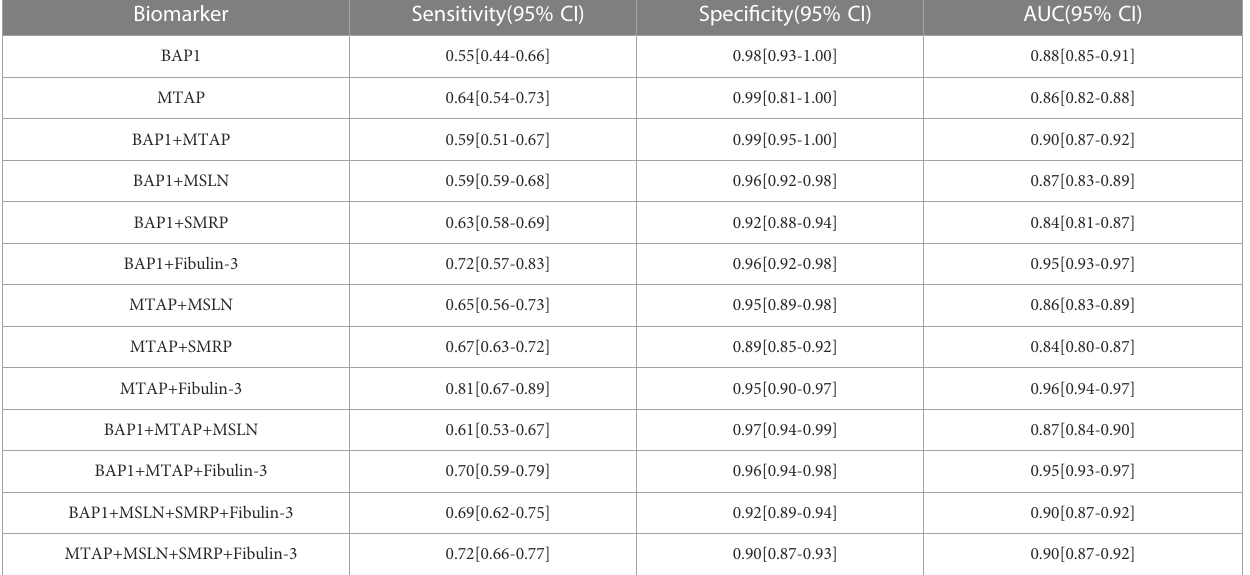
TABLE 2 Summary of results of